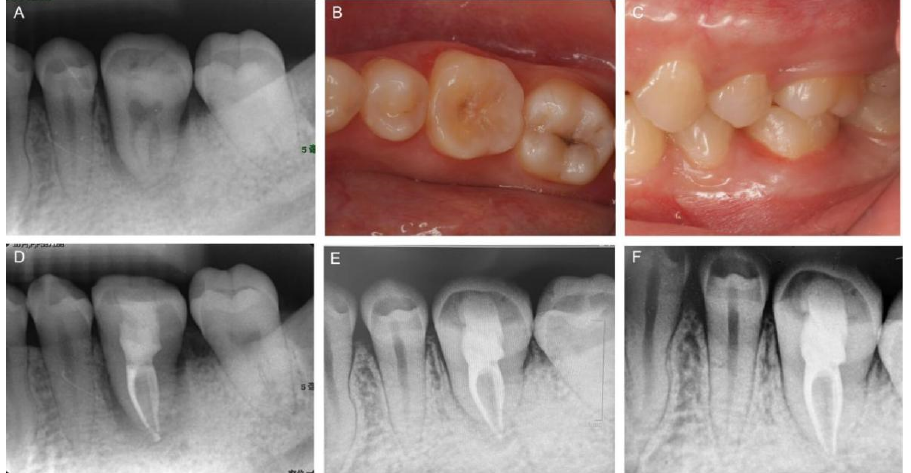
Figure 4. Clinical follow-up. ( A ) Postoperative radiograph taken immediately after autotransplantation. An occlusal view ( B ) and a buccal view ( C ) at the 3-week follow-up. ( D ) Endodontic treatment performed after 3 weeks. The 8-month follow-up radiograph ( E ) and 1-year follow-up radiograph ( F ) showing no signs of root resorption and the normal functioning of the transplanted tooth.